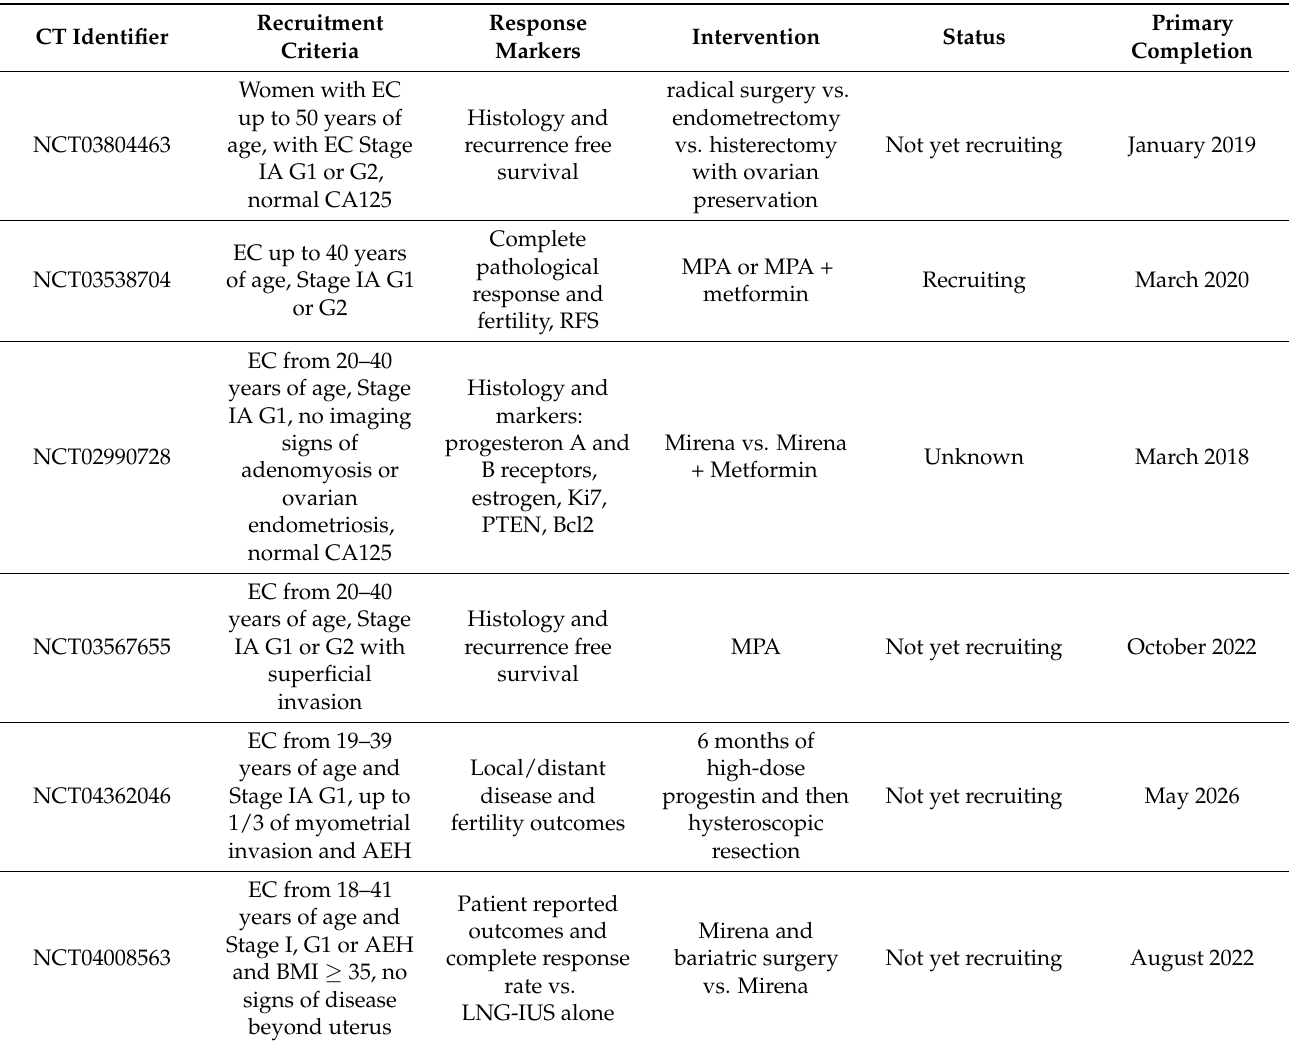
Table 2. Currently ongoing studies of different conservative management options in women with endometrial cancer. CT